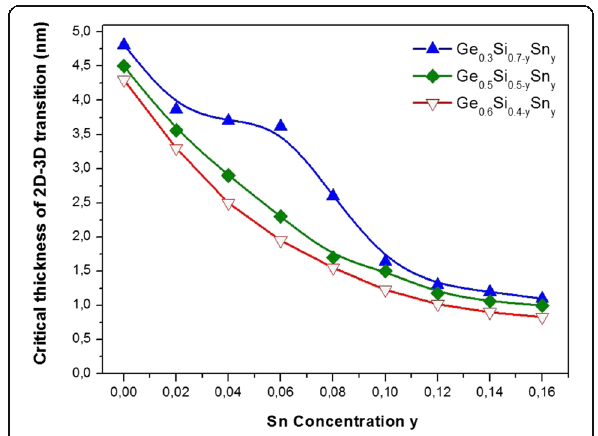
Fig. 2 The critical 2D-3D transition thickness dependences on the GeSiSn film composition at several fixed values of Ge content, Sn content from 0 to 16%, and at the growth temperature of 150 °